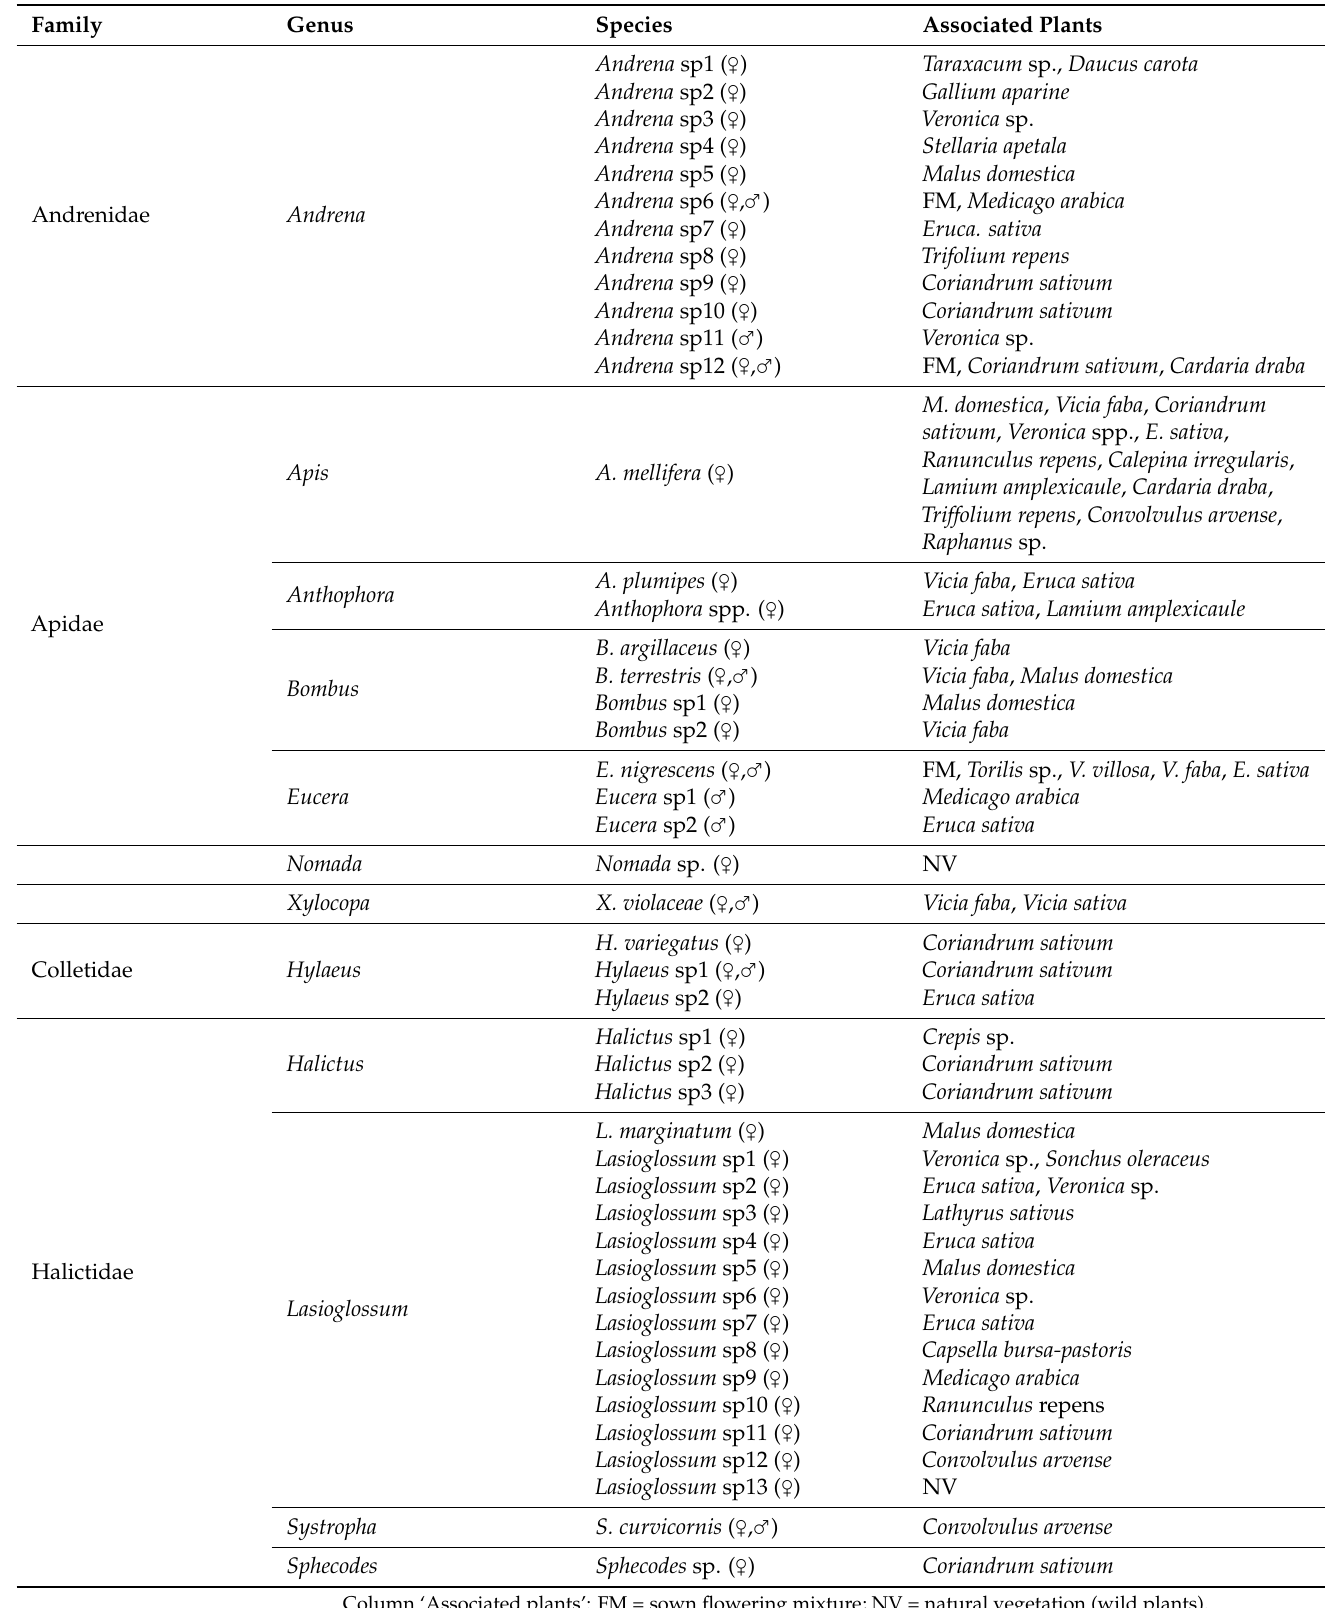
Table 2. Hymenopterous pollinators and associated flowering in sown flowering mixtures and the natural vegetation (wild plants) in apple orchards in Tegea, Peloponnese, Greece,